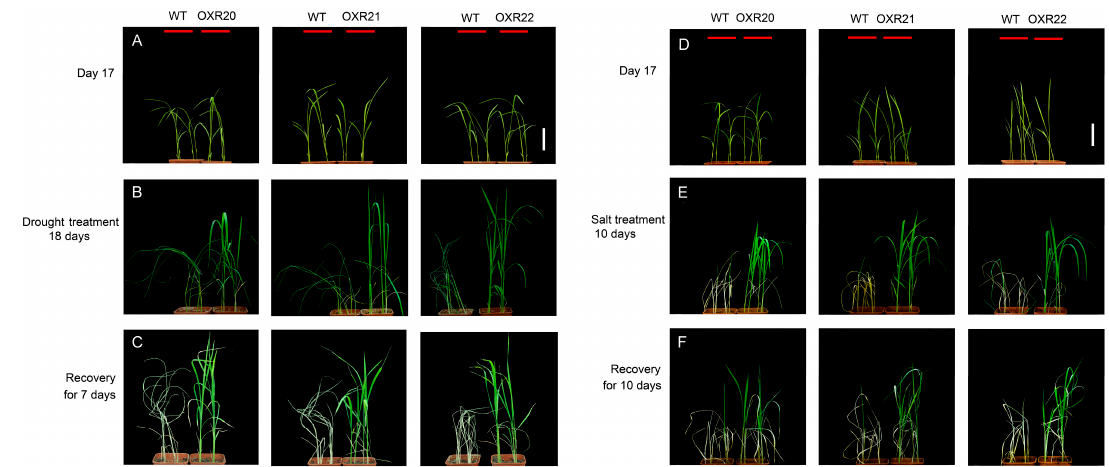
Figure 2. Phenotypes of WT and OXR rice plants with drought and salt treatments in greenhouse. ( A ) 17 days after germination before drought stress treatment; ( B ) 35 days after germination and drought stress treatment for 18 days; ( C ) recovery of drought stress treatment for 7 days; ( D ) 17 days after germination before salt stress treatment; ( E ) 27 days after germination and salt stress treatment for 10 days; ( F ) recovery of salt stress treatment for 10 days. Scale bar = 5 cm.